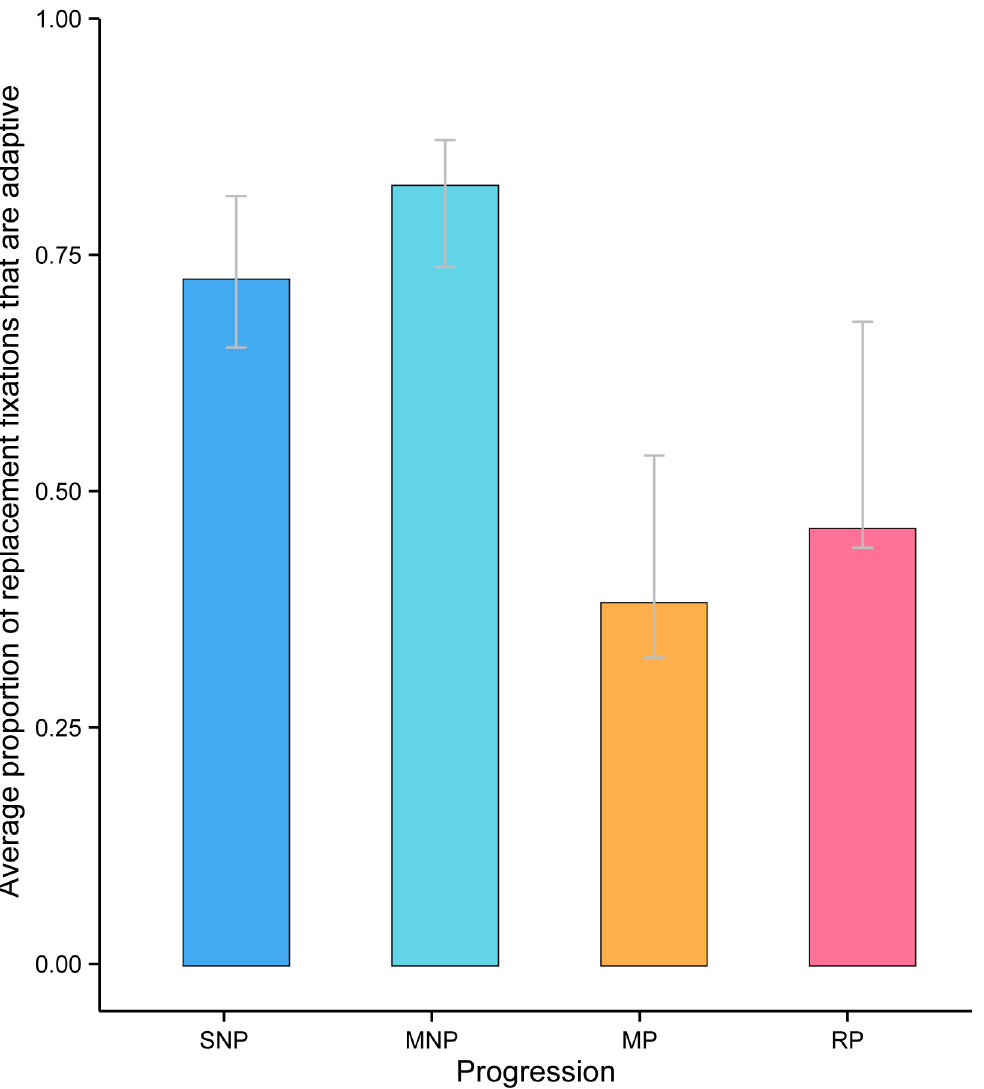
Fig 4. The proportion of high-frequency replacement polymorphisms that are adaptive (i.e. they have risen to high frequency due to positive selection) is significantly different greater in non-progressors (SNP and MNP) than progressors (MP and RP) (Mann-Whitney U-test, P < 0.05). This indicates that the strength of immune selection is significantly different among individuals with different disease outcomes. Error bars correspond to the interquartile range estimated from 250 bootstrap samples.